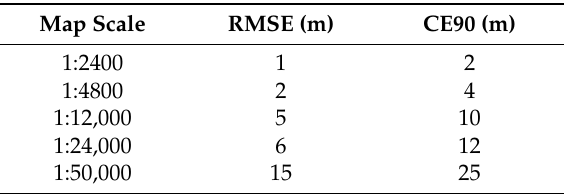
Figure 11. Statistics on the NAD sensor’s planimetric accuracy without GCPs. Table 6. Approximate map scale equivalencies based on the United States National Map Accuracy Standard